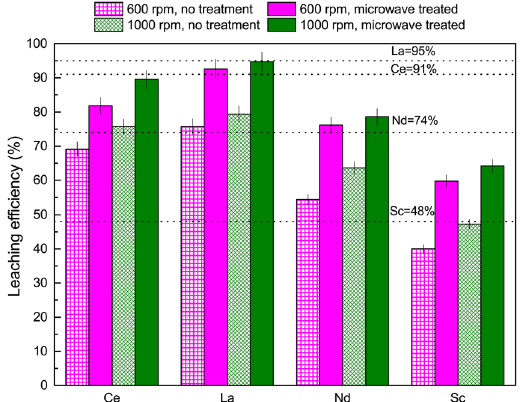
Figure 7. The effect agitation on the leaching efficiency of REE from bauxite residue in 1.5 M H 2 SO 4 at 90 °C (with and without microwave pretreatment) within 30 min residence time. The dashed lines represent the maximum leaching efficiency that could be achieved using 3 M HNO 3 at 90 °C without microwave pretreatment. Error bars represent the standard error of the mean for four